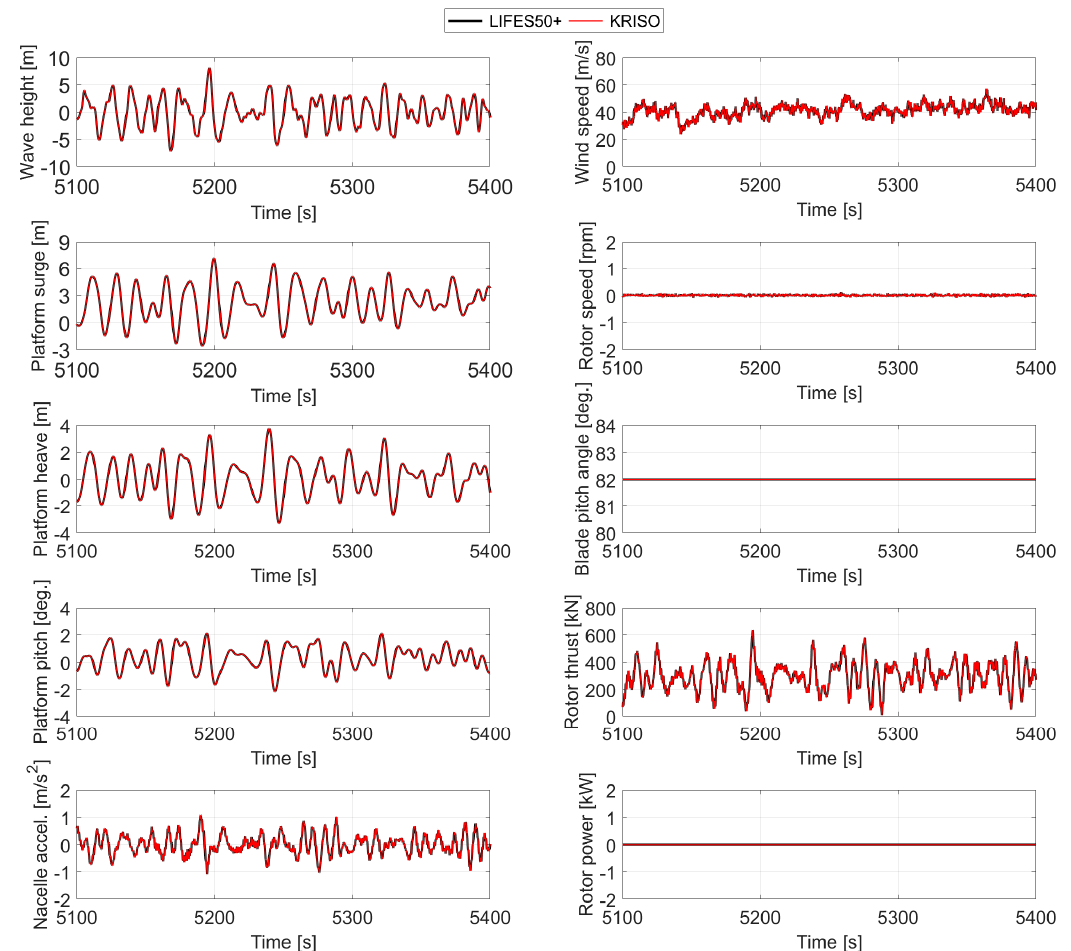
Figure 2. Validation of the responses to DLC6.1 for the OO-Star Wind Floater Semi 10 MW.